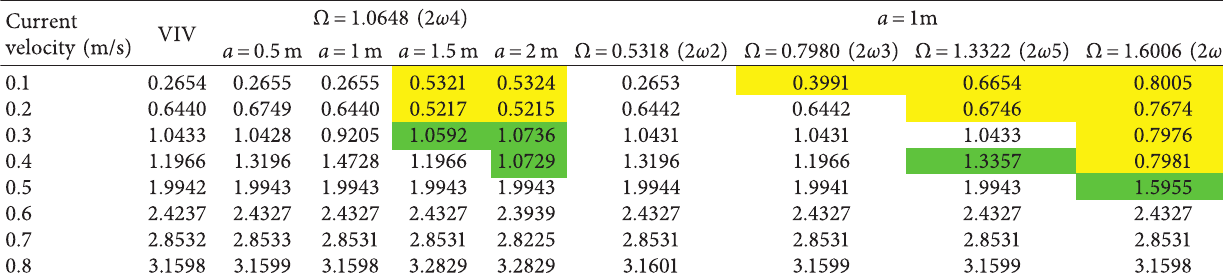
Table 3: Dominant frequencies of TTR (rad/s).